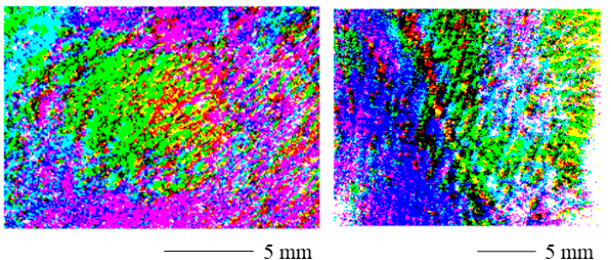
Figure 7. Threshold polarization stain image for a contracture scar ( left ) and a hypertrophic scar ( right ). The scarred portions can easily be identified. Near the margins of the image, the values change. The curved skin geometry could be the cause of this.